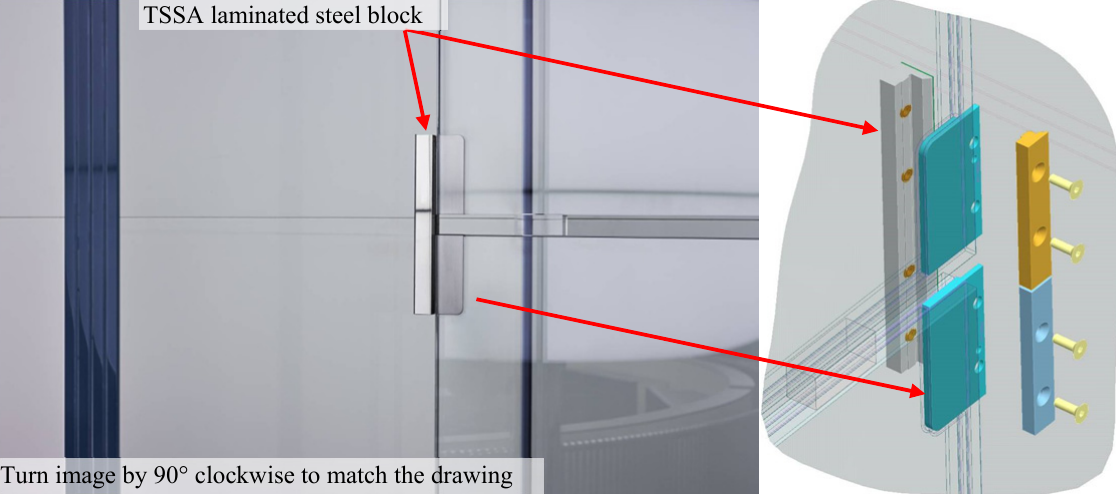
Fig. 13 TSSA bonded elements in substitution with laminated